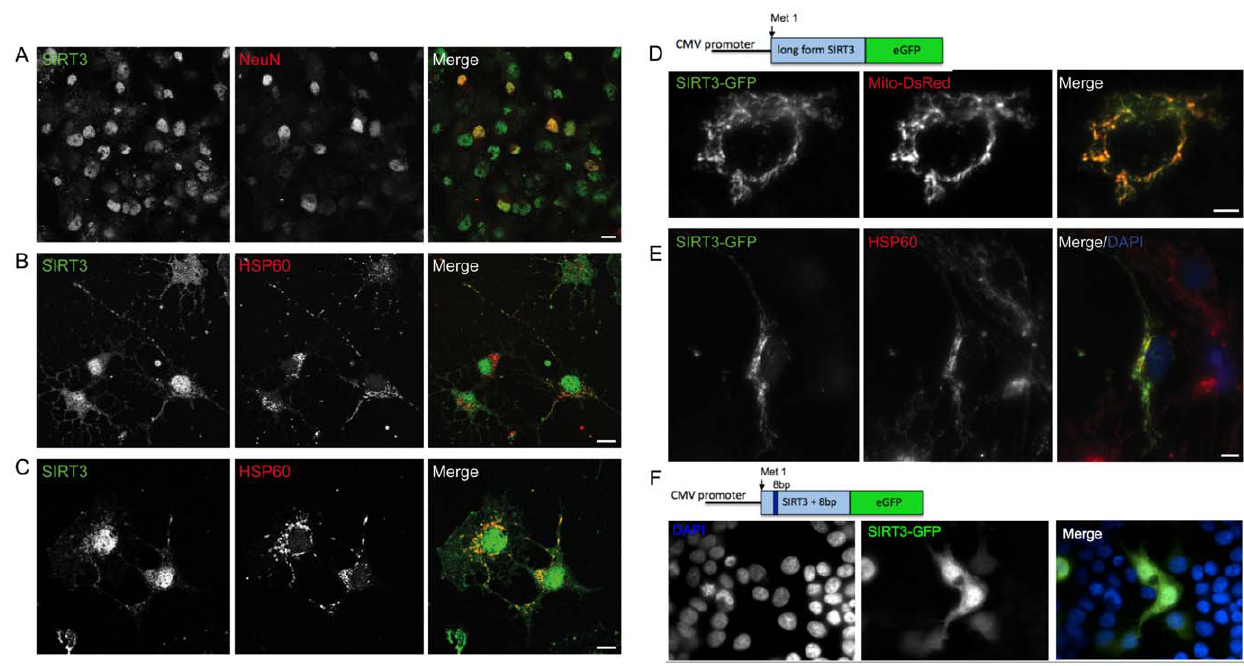
Figure 1. Subcellular localization of CNS SIRT3. Confocal analysis of SIRT3 subcellular localization: A. SIRT3 is expressed in neurons and glia. Left : SIRT3 immunohistochemistry in primary hippocampal cultures. Middle: NeuN, Right : red and green channels merged. B, C. SIRT3 expression localizes to the nucleus and mitochondria of the cell body, axons and dendrites. Left : SIRT3 immunohistochemistry. Middle: mitochondrial HSP60, Right : red and green channels merged. Scale bar A–C=10 m m D and E. Over-expression of long-form SIRT3eGFP results in exclusively mitochondrial localization. D. HeLa cells were co-transfected with Mito-DsRed and ‘long-form’ SIRT3eGFP plasmids (left: green SIRT3eGFP, middle: red Mito-DsRed, right: merge of channels). E. Primary hippocampal cultures were transfected with a ‘long-form’ SIRT3eGFP plasmid, fixed and immunohistochemistry performed for HSP60 (middle: red) and eGFP (left: green, right: merge of channels). Scale bar D, E=5 m m. F. Over-expression of ‘short-form’ Sirt3eGFP results in cytoplasmic and nuclear localization. HEK293T cells were transfected with ‘short-form’ SIRT3eGFP, fixed and labeled with DAPI (left panel) and anti-GFP (middle panel, right: merge of channels).